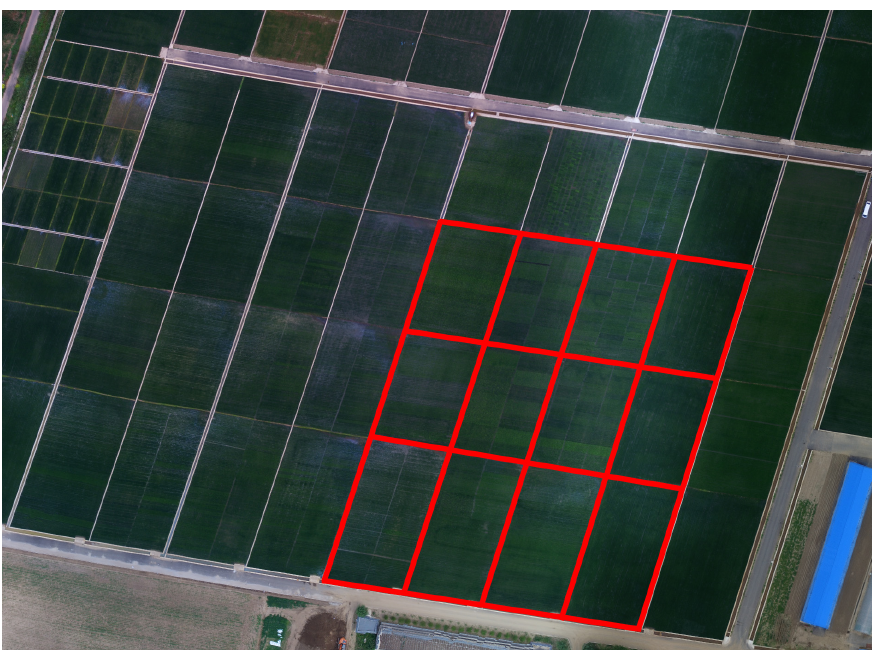
Fig 1. Test plots used for data